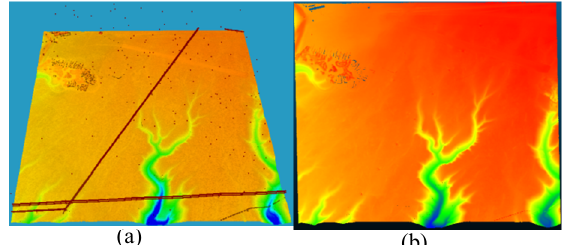
Figure 3. The 3D point cloud display of test data. (a) the raw point clouds; (b) the point cloud after preprocessing